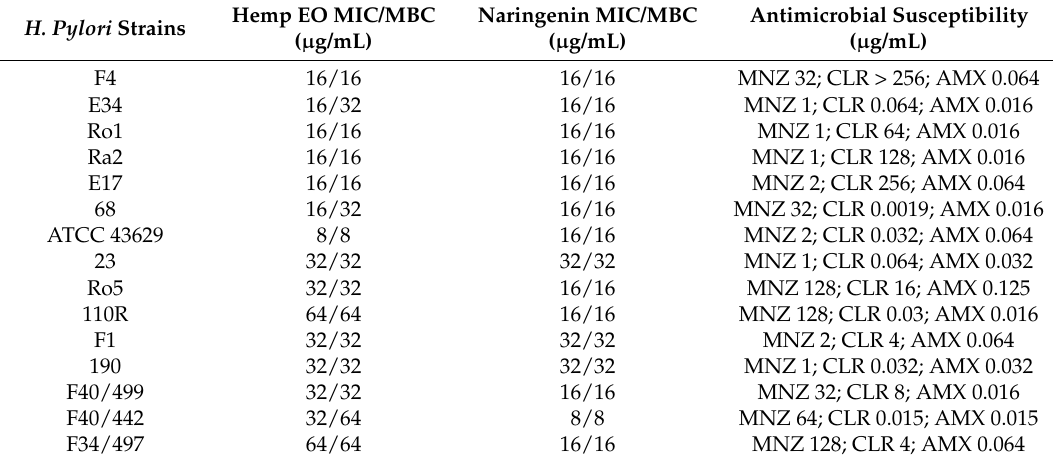
Table 7. Evaluation of the minimum inhibitory concentration (MIC) and minimum bactericidal concentration (MBC) of hemp EO and naringenin against clinical Helicobacter pylori strains with different antimicrobial susceptibility